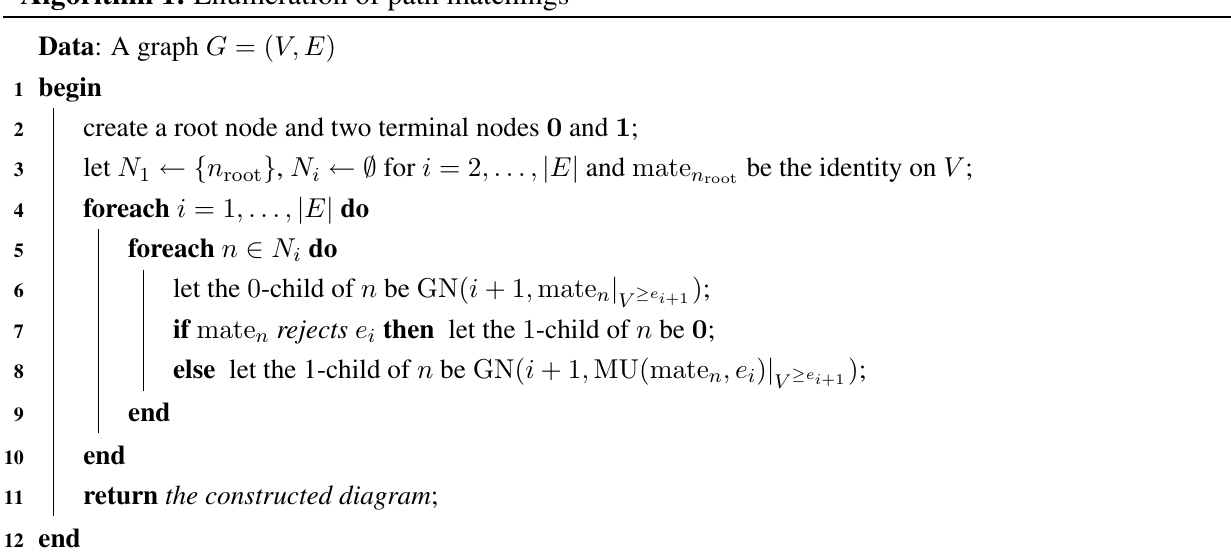
Algorithm 1: Enumeration of path